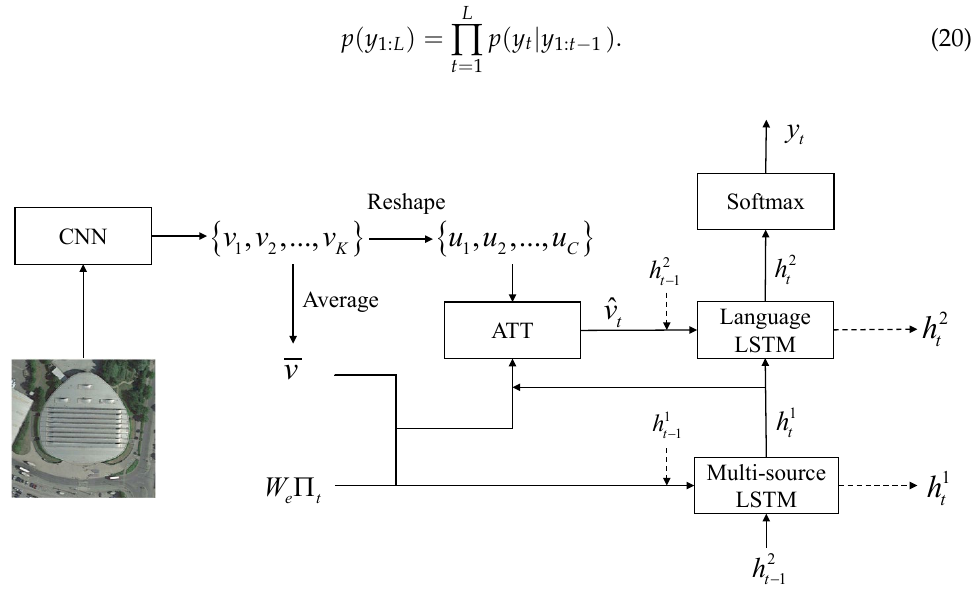
Figure 4. Overall framework of the proposed method. The CNN features of RSIs are first extracted. In the decoder module, CNN features are modeled by the ATT block, which can be the designed MSIAM or MSISAM. The multi-source LSTM and Language LSTM are used to preliminarily transform visual information into semantic